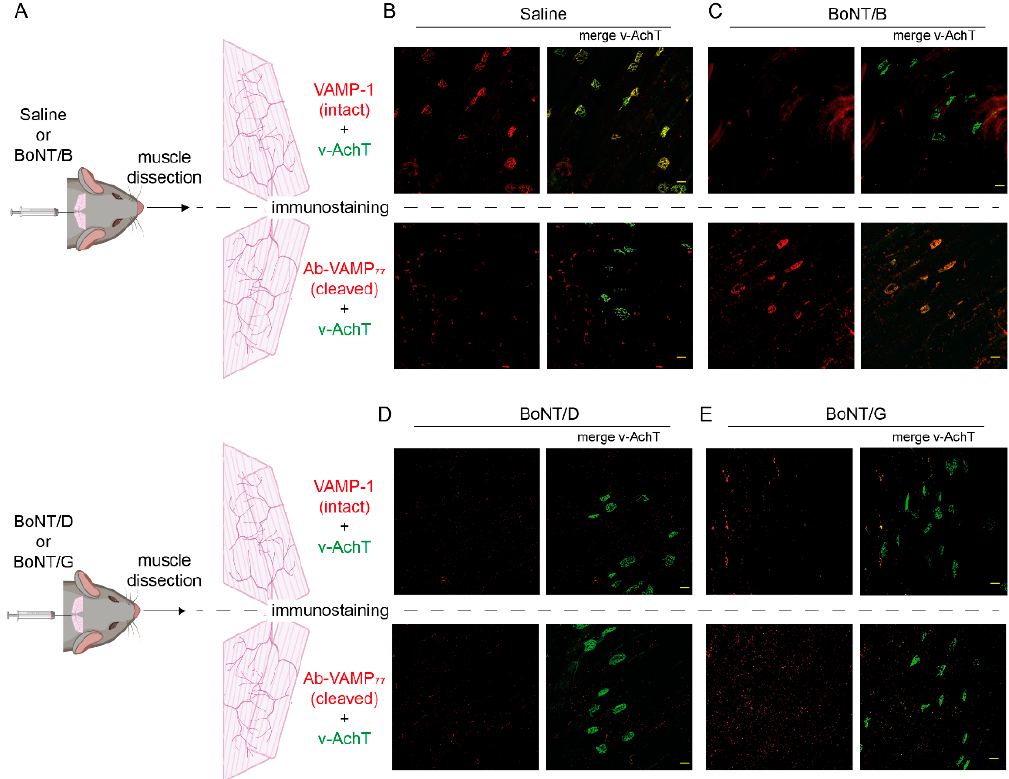
Figure 3. The Ab-VAMP 77 polyclonal antibody detects VAMP cleavage by BoNT/B at the neuromuscular junction. ( A ) Scheme showing the staining of the two LAL muscles collected after injection of either saline or BoNT/B (top panel) or of either BoNT/D or BoNT/G (bottom panel) and the following immunostaining of one LAL with an antibody against intact VAMP-1 (top panels) or with the Ab- VAMP 77 antibody (bottom panels). In both cases, the muscles were also stained for the vesicular protein marker v-AchT. B-C-D-E) Representative images of whole-mount LAL muscles injected with either saline ( B ) or BoNT/B ( C ) or BoNT/D ( D ) or BoNT/G ( E ) stained for intact VAMP-1 (red in top panels) or cleaved VAMP (red in bottom panels). The right panels of each condition show the merge with v-AchT (green). Scale bar = 25 µm 2.4. The Antibody against Cleaved-VAMP Specifically Detects the Activity of TeNT in the Central Nervous System The strategy to exploit the protease activity as an amplifying factor to track down the tissue distribution of CNT has been instrumental in showing that BoNT/A action also acts in the CNS [79–81]. Notably, an antibody recognizing the BoNT/A-cleaved SNAP-25 was widely used to show that, upon intramuscular or subcutaneous injection, the toxin moves from the injection site via intra-axonal retrograde transport, reaching different areas of the CNS in an active form [43–45,47,48,50] even two synapses away from the injection site [46]. Therefore, we decided to test whether Ab-VAMP 77 can detect the cleavage of VAMP via TeNT in the CNS. We opted for a model of local tetanus generated by injecting a sub- lethal amount of TeNT at the level of the LAL muscles, thereby causing a spastic paralysis confined to the muscles of the ears [11]. Two days after injection, we collected the brain stem and made cryoslices of the facial nucleus. As shown in Figure 4A, Ab-VAMP 77 raised a very strong and bright, yet extremely confined staining for cleaved VAMP at the level of the seven dorsomedial and seven ventromedial subnuclei (7DM and 7VM) [82], the areas populated by the motor efferents innervating the LAL muscles. Of note, as shown by the magnification, in this case the signal also appeared as rounded varicosities, once again consistent with staining of presynaptic puncta. Moreover, it was restricted to areas